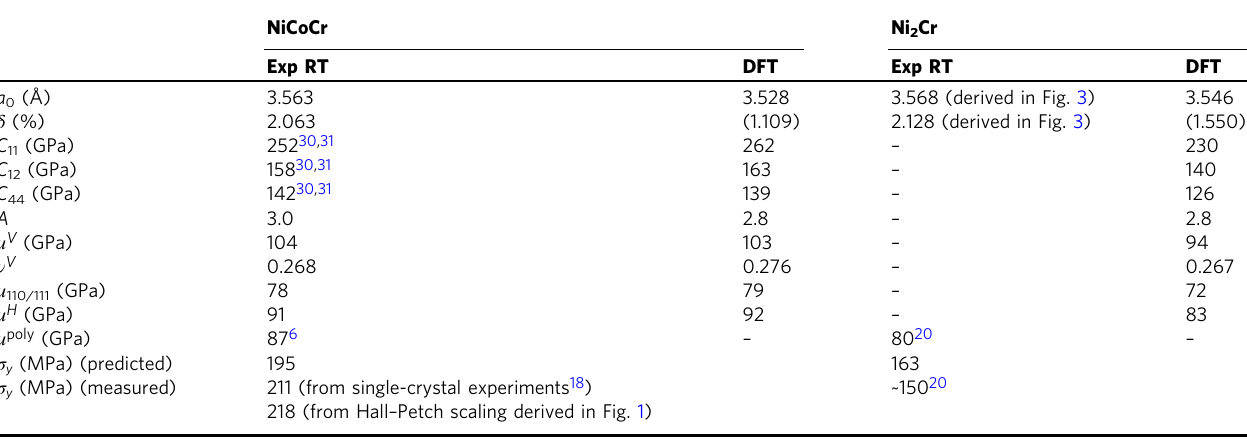
Table 1 Material parameters and the resulting yield strength prediction at T = 300 K and strain rate 5 × 10 − 4 s − 1 for NiCoCr and 10 − 4 s − 1 for Ni 2